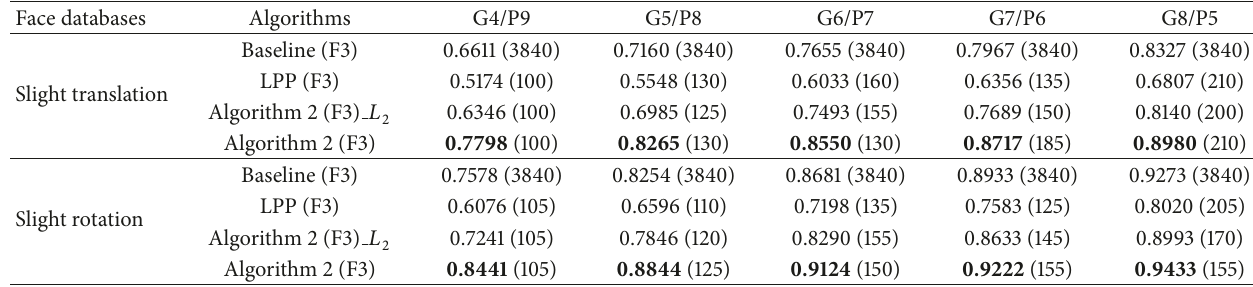
Table 15: The recognition rates on slight translation and rotation AR face databases over “F3” features; recognition rates (dimensionality).